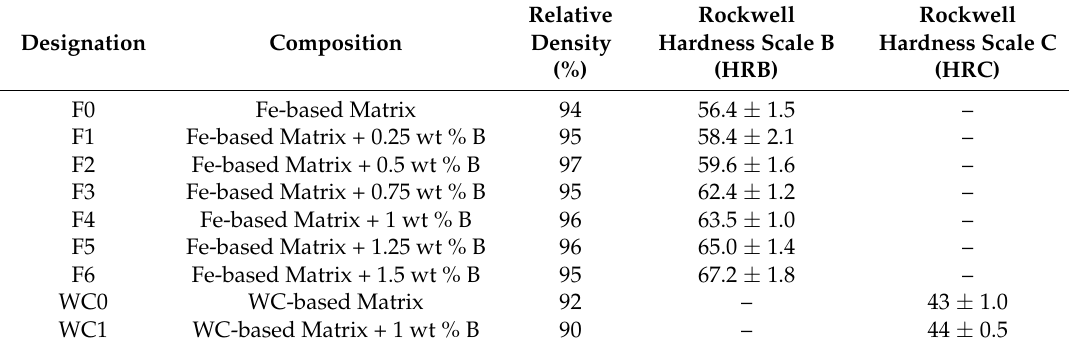
Table 1. The designation, composition, and physical properties of